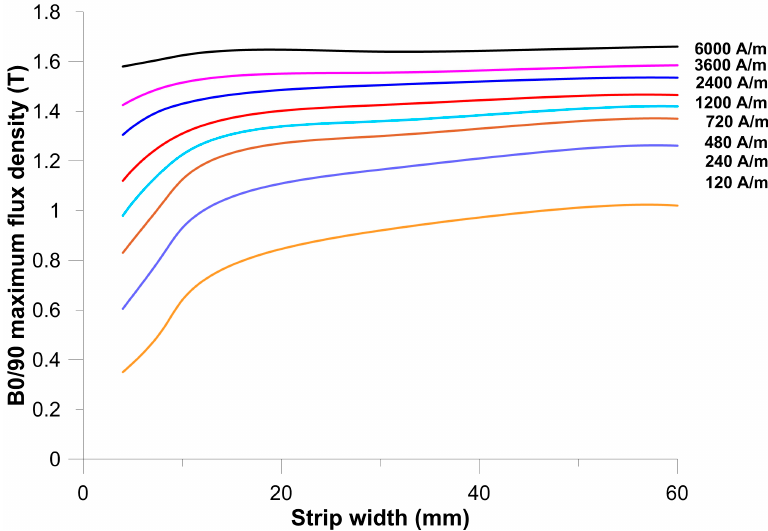
Figure 9. Calculated B 0/90 maximum flux density curves for M250-35A material. The specified magnetic field strengths are shown in the image.